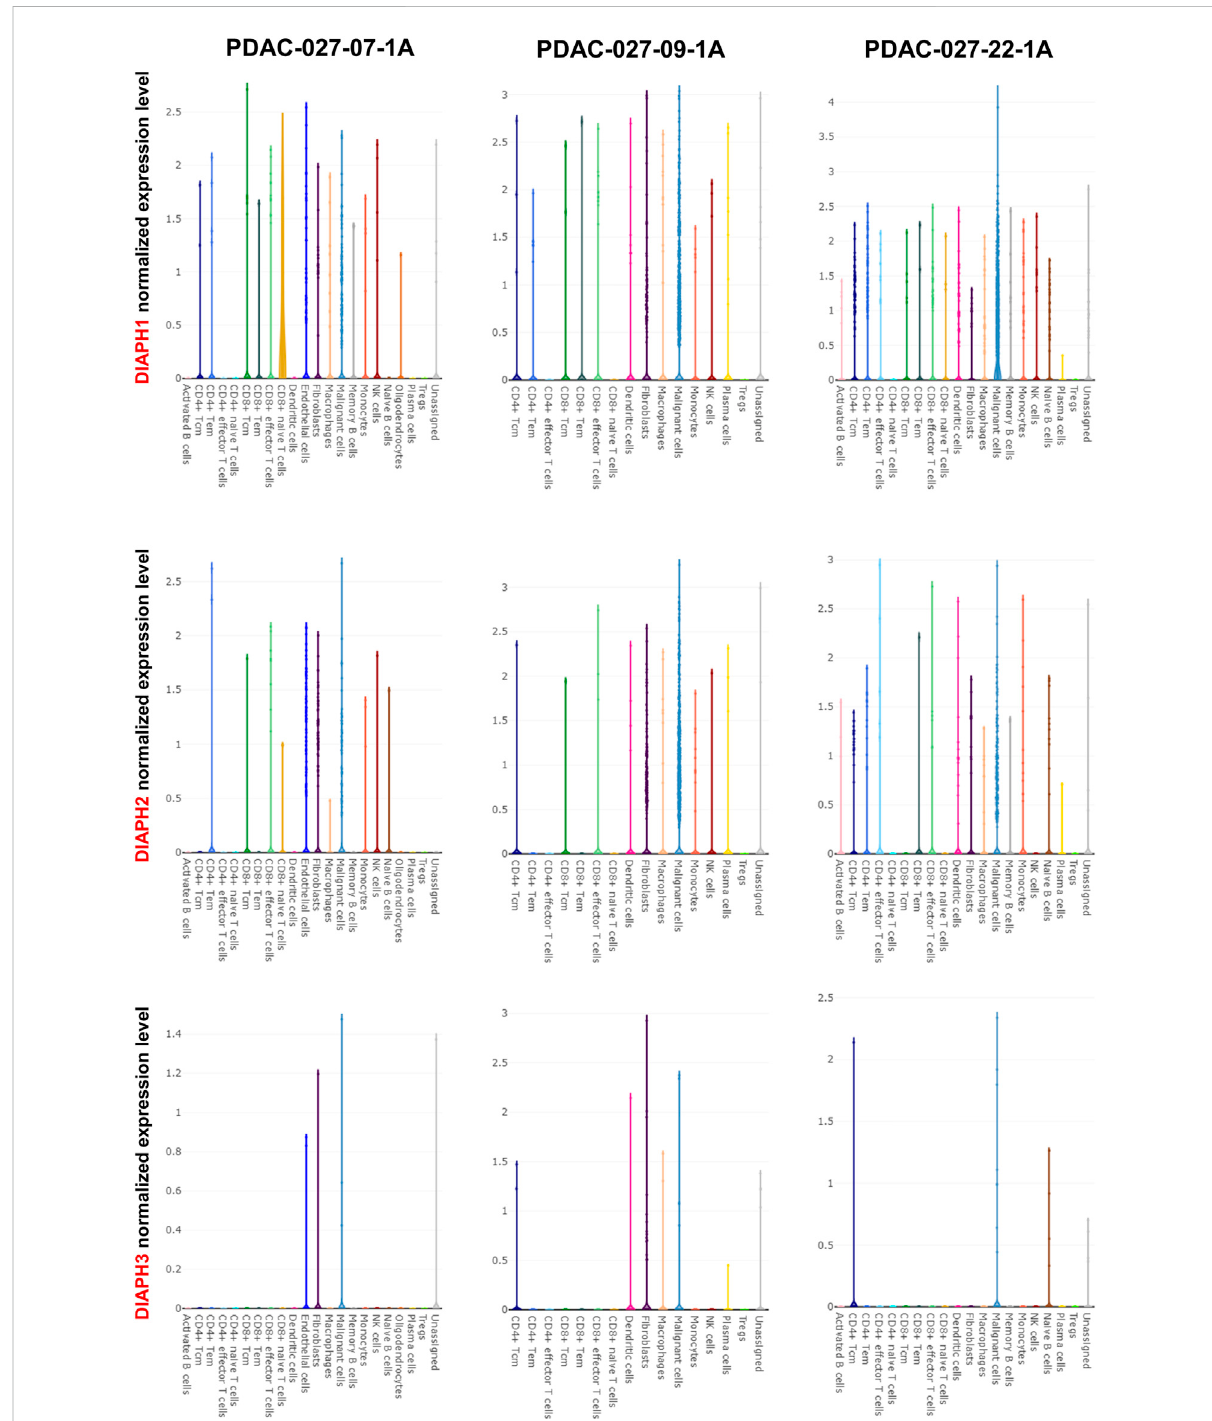
FIGURE 9 Single-cell data analysis of DIAPHs expression in PAAD. DIAPHs were mainly expressed in malignant cells and also abundantly expressed in various immune